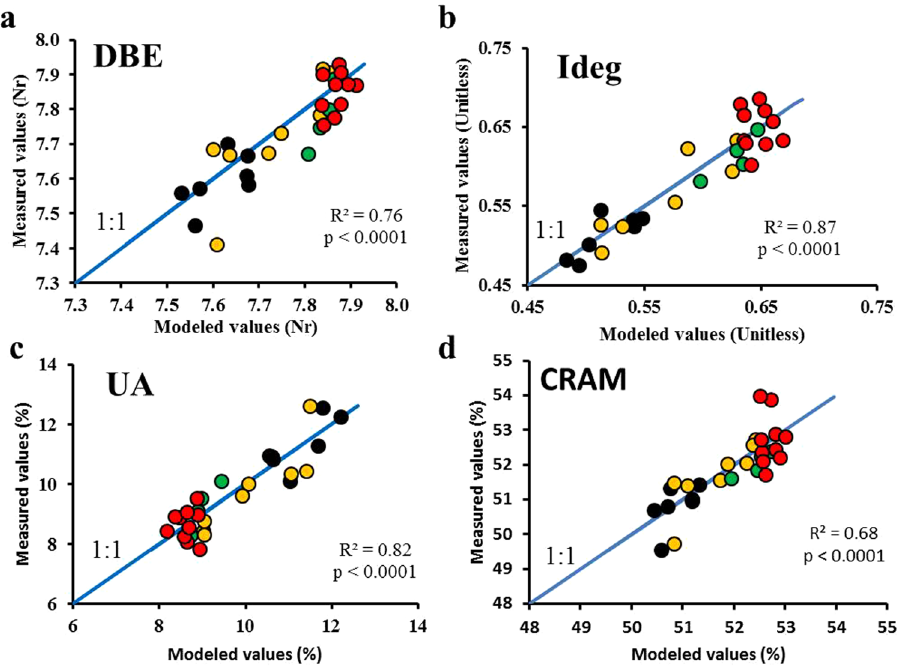
Figure 5. Comparison of modeled and measured molecular DOM properties. The modeled values were calculated using the multiple linear regression models and the measured values were obtained from the FT- ICR-MS analysis for ( a ) double bond equivalent (DBE), ( b ) degradation index (Ideg), ( c ) unsaturated aliphatic compounds and ( d ) carboxyl-rich alicyclic molecules (CRAM). Colored dots represent samples collected at different layers, deep chlorophyll maximum (black), Levantine intermediate water (yellow), oxygen minimum layer (green) and deep waters (red). Note that there is a random deviation from the 1:1 line (blue line). For the CRAM regression (plot d ) red dots with higher measured values correspond with samples collected at station 1 and the black and yellow dots, with lower measured values, correspond with samples collected at station 7 and 1,